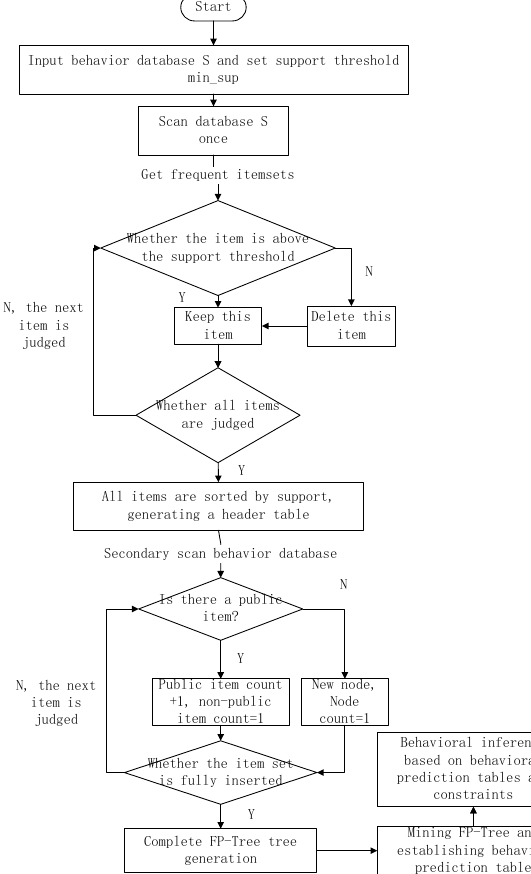
Figure 1 Improved FP-growth algorithm flow